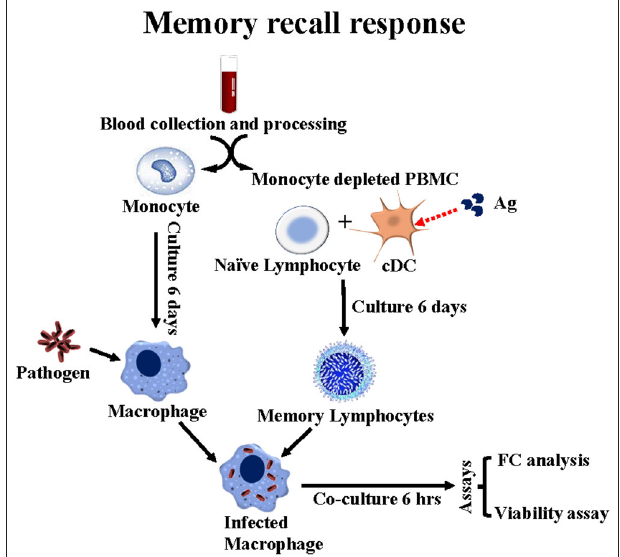
FIGURE 2 | Flow diagram illustrating the ex vivo platform developed in cattle to study the recall response to stimulation with APC primed with Map/rel or MMP. PBMC from a steer vaccinated with Map/rel are separated into CD14 + monocytes to develop monocyte derived 14 + macrophage target cells and monocyte depleted PBMC for stimulation with CD209 + bDC stimulated with Map/rel or MMP to elicit a recall response. mdBMC containing bDC, CD4, CD8, CD335 NK cells and γδ T cells are phenotyped by flow cytometry. A viability assay is used to quantitate the relative proportion of bacteria killed by CD8 CTL. See methods for description of assay (